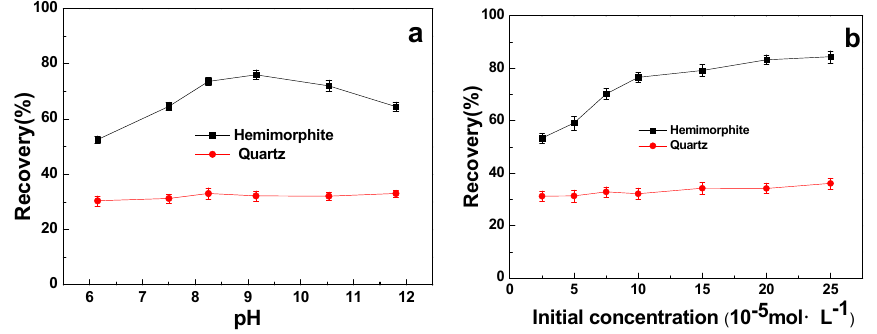
recommended that an efficient flotation separation of hemimorphite from quartz could be reached by using HDDPA as a collector.